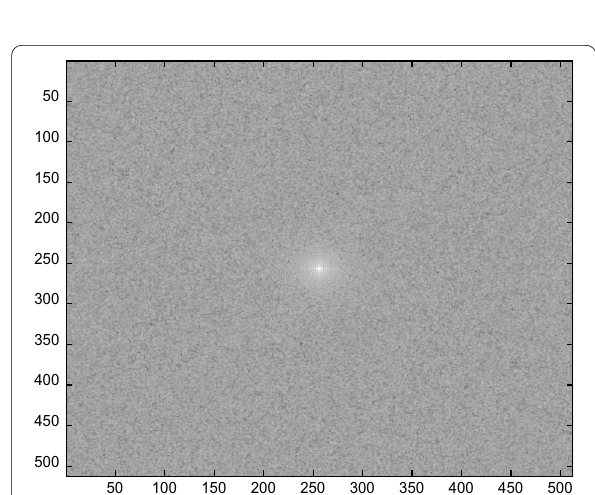
Fig. 5 The modulated speckle pattern which is the FT of the multiplication of the diffuser and the circular aperture. It is located before the 1st microscope objective